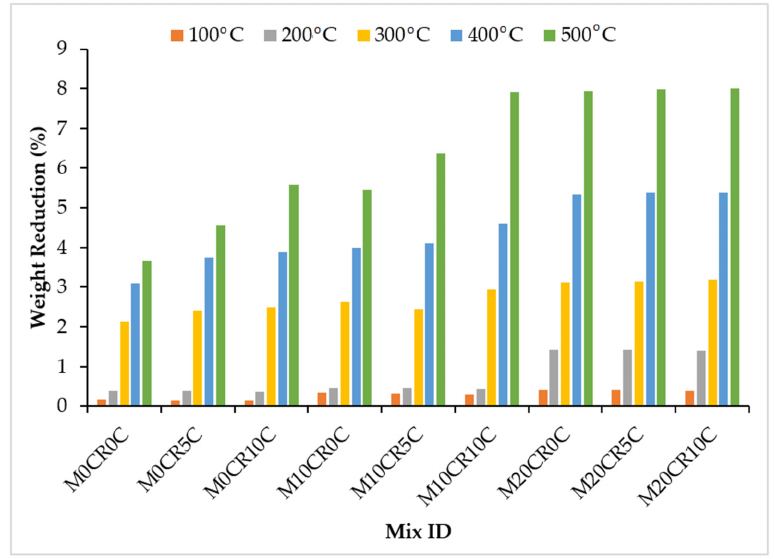
Materials 2022 , 15 , 488 Figure 6. Effects of elevated temperature on weight of SCC mixes containing CR and CCW.